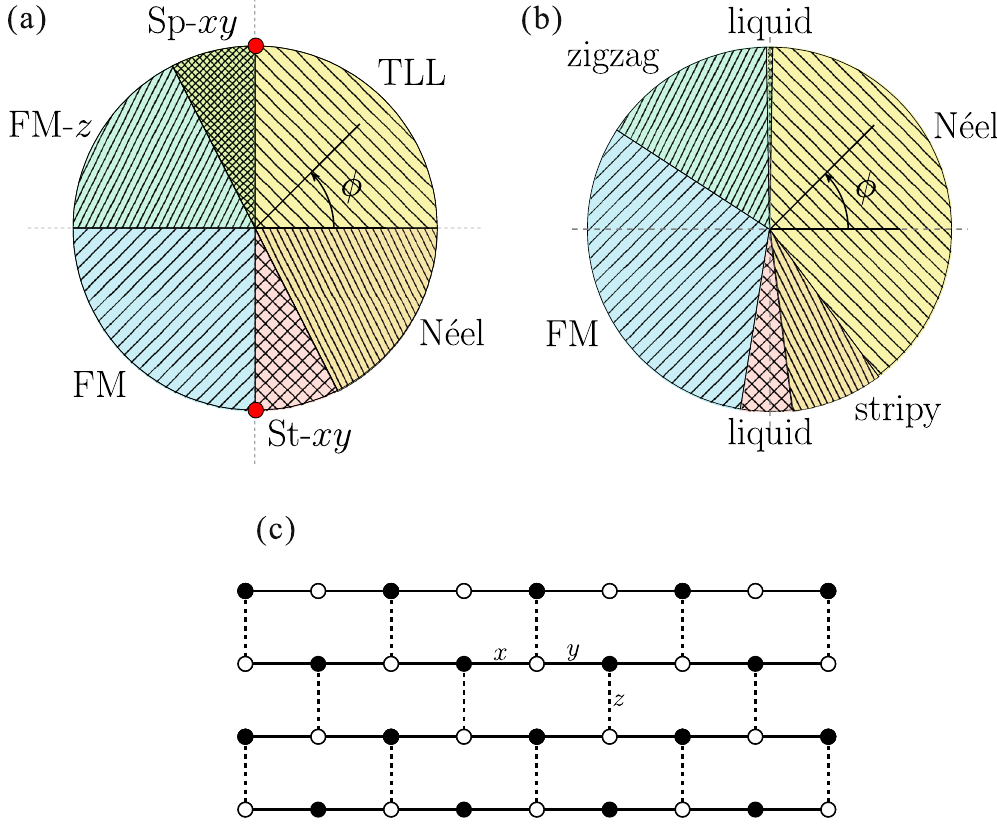
Figure 9. ( a ) Ground-state phase diagram of the 1D KH model. ( b ) Ground-state phase diagram of the honeycomb-lattice KH model, where the same notations as in Eq. (1) are used for K and J . ( c ) Brick-wall lattice created by coupling the 1D KH chains by the z -bond. This is topologically equivalent to the honeycomb